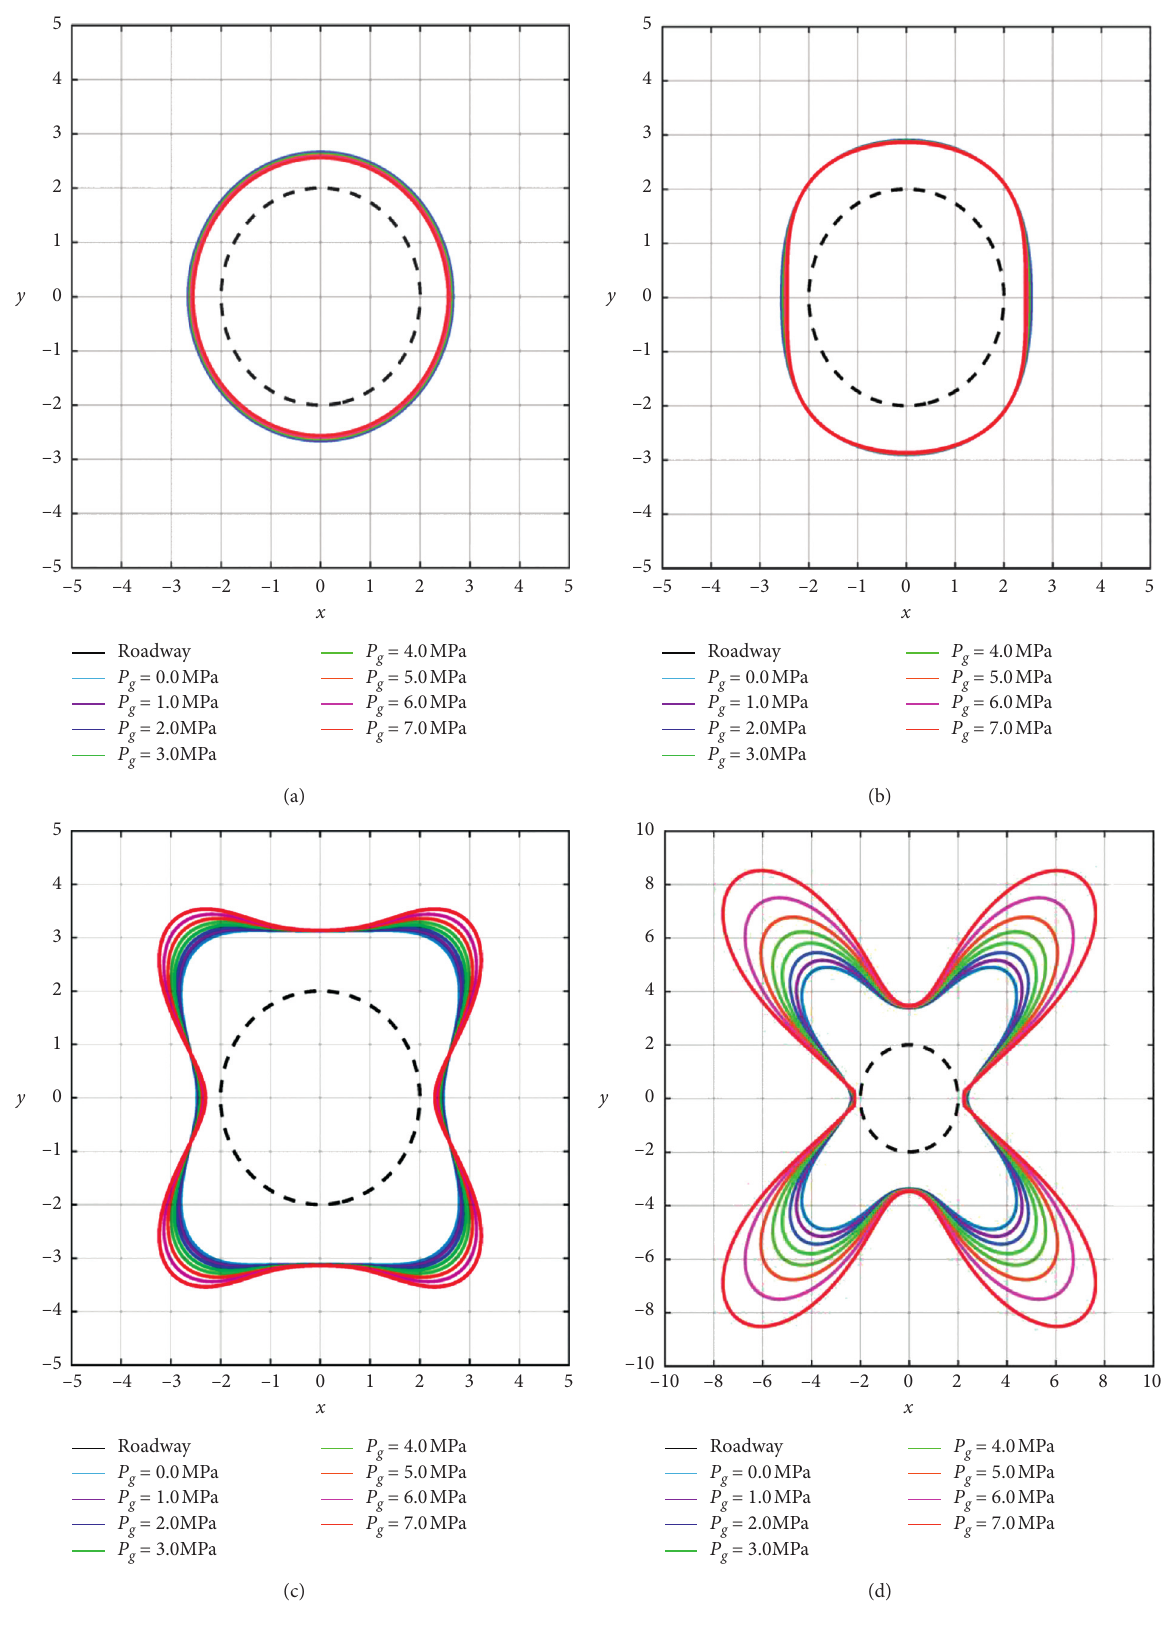
Figure 6: Distribution of plastic zone for various gas pressures. (a) λ � 1.00. (b) λ � 1.48. (c) λ � 1.96. (d) λ �